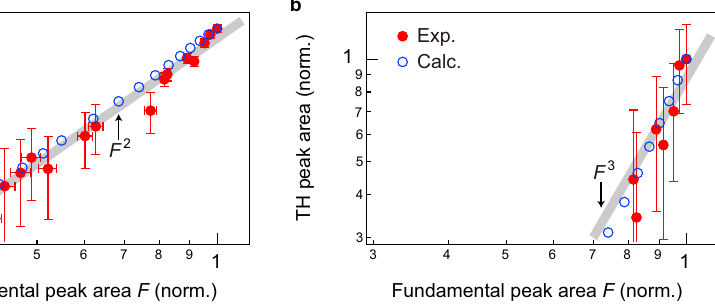
Fouriertransformamplitudesinthespectra.Theerrorbarsrepresentthenoise fl oor inthe spectra, which is obtained by integrating the Fourier transform amplitudes of thecasefor E THz =0.2MVcm − 1 overtherangefrom1.25to1.71THz.Thegraylinesare proportional to the square and cube of the fundamental peak area F